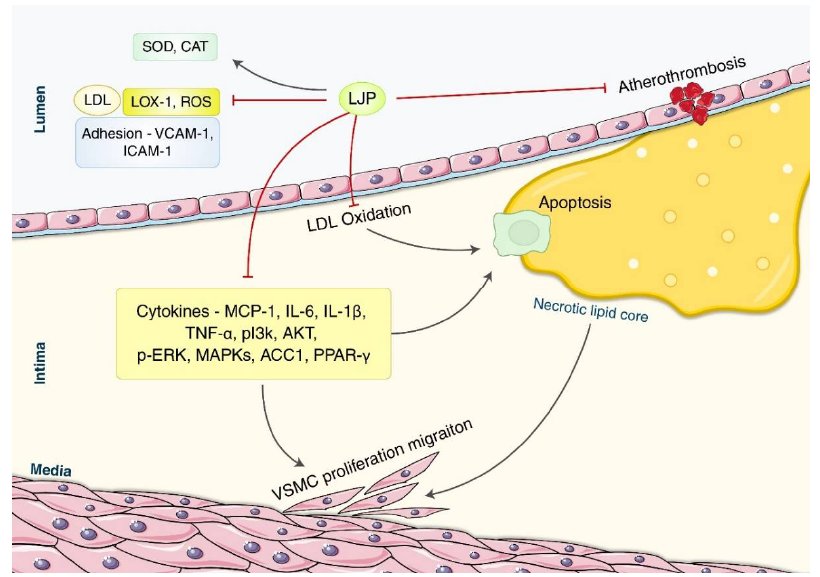
Figure 4. A schematic overview of the main mechanisms of LJP against atherosclerosis . Endothelial dysfunction causes lipid retention in the intima, the induction of endothelial expression of adhesion molecules, and the secretion of chemotactic substances, promoting leukocyte recruitment, adhesion, and transmigration into the vessel wall in patients with atherosclerosis. VSMC migrates from the media into the intima after dedifferentiating from a contractile to a proliferating pheno- type. LJP inhibits atherothrombosis by interrupting oxidative stress-related lipid peroxidation and the PI3K/Akt signaling pathway, promoting cell growth, proliferation, and angiogenesis. It also reg- ulates inflammatory and macrophage-related cytokines IL-6, IL-1β, and TNF-α. LJP treats athero- sclerosis through its inhibitory action on the enhanced proliferation and migration of VSMC in ath- erosclerosis patients. ACC1: acetyl-CoA carboxylase; CAT: catalase; ICAM-1: intercellular adhesion molecule-1; IL: interleukin; LJP: Laminaria japonica ; LOX-1: lectin-like oxidized low-density lipopro- tein receptor-1; LPL: lipoprotein lipase; MAPKs: mitogen-activated protein kinases; MCP-1: mono- cyte chemoattractant proteins; (p-)ERK: (phosphorylated); PI3K/Akt: phosphoinositide 3-ki- nase/protein kinase B; PPAR-γ: peroxisome proliferator-activated receptors-γ; ROS: reactive oxygen species; SOD: superoxide dismutase; TNF-α: tumor necrosis factor-α; VCAM-1: vascular cell adhe- sion molecule-1; VSMC: vascular smooth muscle cells. 3.1.4. Hyperlipidemia/Fatty Liver Two studies of anti-hyperlipidemia and fatty liver effects of LJP were reposted (Table 4). Zhang et al. (2020) reported that macroalgae LJP (MLJ) was a potential treatment for hyperlipidemia as high-fat mice were able to undergo hypolipidemic effects after being administered with MLJ [39]. The mechanism underlying this efficacy was increased SOD and glutathione peroxidase (GSH-Px). Zhang et al. reported that Lactobacillus brevis FZU0713-fermented LJP (FLJ) had a ben- eficial effect in hyperlipidemic rats [40]. According to a previous study, the oral admin- istration of FLJ regulated hepatic mRNA levels of the gene, thereby reducing the serum levels of TC and TG and increasing the fecal levels of acid acetate, propionate, and isobu- tyrate. A dieckol-enriched extract of LPJ was found in a HFD-induced non-alcoholic fatty liver disease mouse model, which had a substantial hypolipidemic impact [41]. They dis- covered that taking 5 mg/kg of polyphenols orally for four weeks decreased the visceral fat index, plasma and hepatic lipid levels (TG, TC, HDL, LDL), and hepatic steatosis.